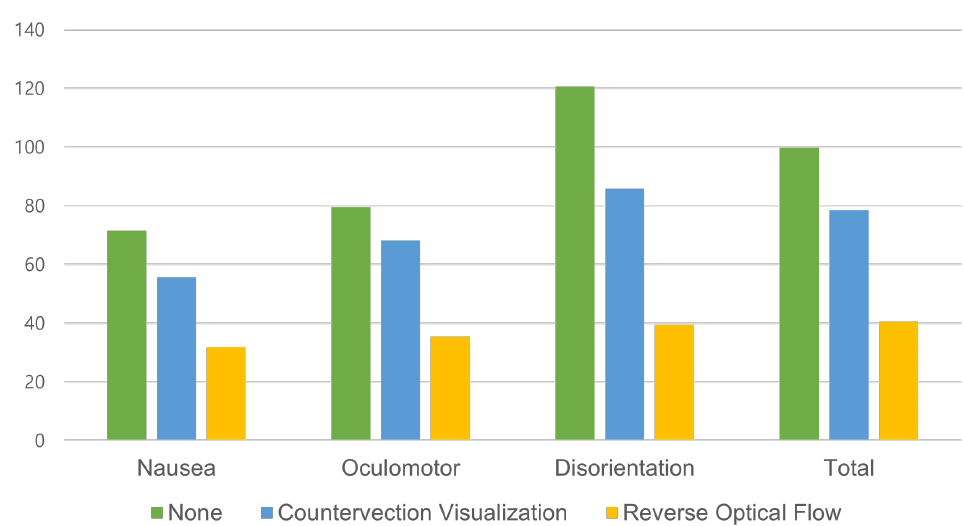
Figure 3. Comparisons of the “after” levels of simulation sickness by the SSQ in the three sickness categories and the total. A clear trend is seen where, in the none condition, the sickness was the highest, which was reduced by the countervection striped bar visualization (CV) and further by the reverse flow visualization